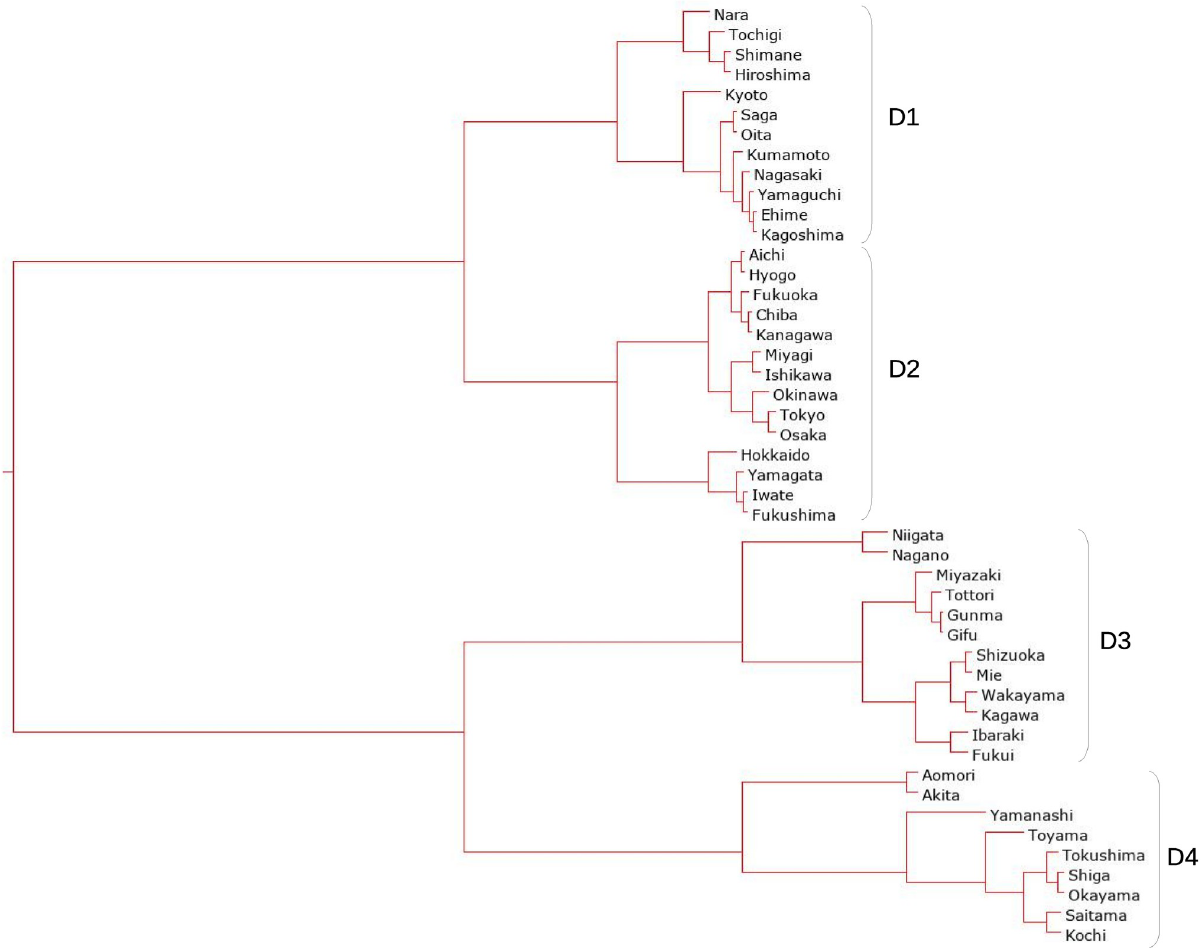
Fig 9. A dendrogram for interval-valued seasonal indices in domestic guests for